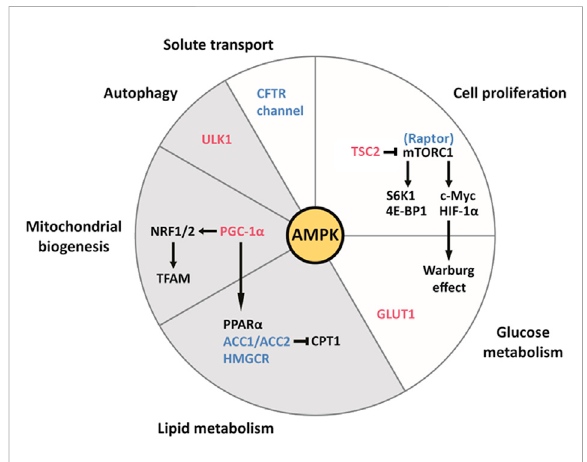
FIGURE 2 The pleiotropic effects of AMPK on cell function and metabolism in the kidney, and their relevance to ADPKD and obesity-related kidney disease. AMPK activates the downstream effectors colored in red and inhibits those colored in blue. Each slice of the pie chart summarizes pathways involved in the pathogenesis of ADPKD (white and grey) and lipid-induced nephrotoxicity seen with obesity (grey only). Clockwise from the top. AMPK inhibits mTORC1 by directly inhibiting the Raptor component of the complex and by activating TSC2, which inhibits mTORC1. mTORC1 is highly active in cyst cell linings and drives cellular proliferation through its downstream effectors S6K1